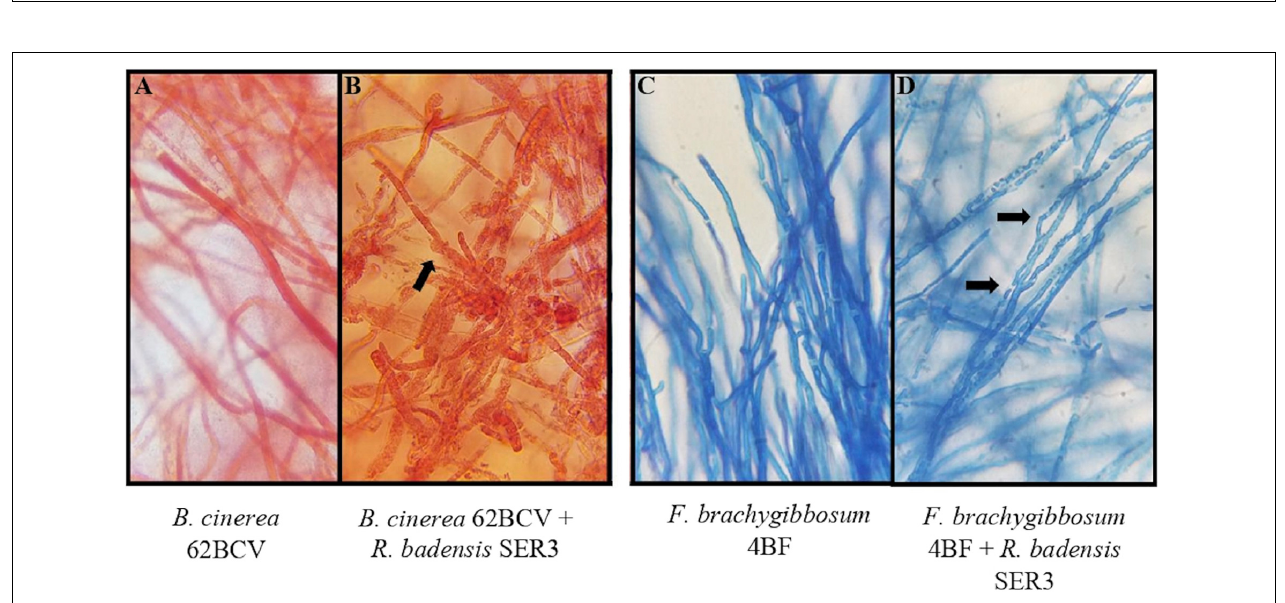
FIGURE 5 | Effect of SER3 on mycelial morphology of (A,B) B. cinerea and (C,D) F. brachyggibosum . Panels (A,C) represent the controls, Panels (B,D) show the interaction between the bacterial strain and each of the pathogens. Arrows indicate distortion of hyphae ( × 100 magnification).